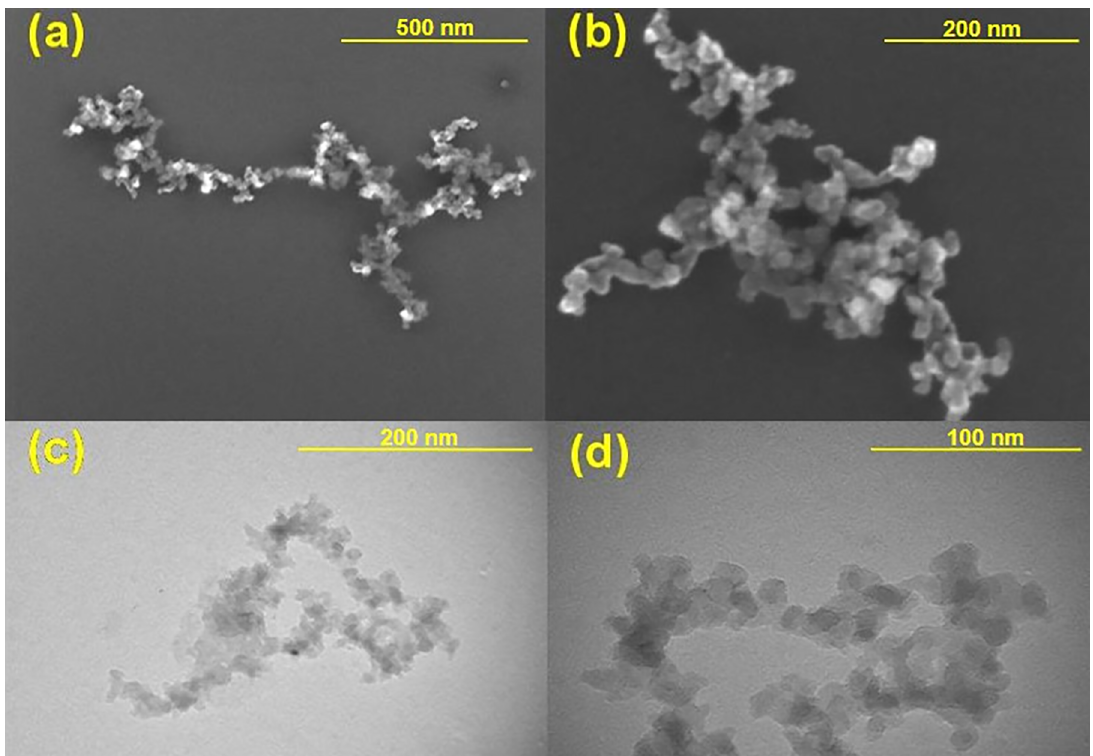
Figure 3. SEM micrographs (a) and (b); and TEM micrographs (c) and (d) of fumed silica